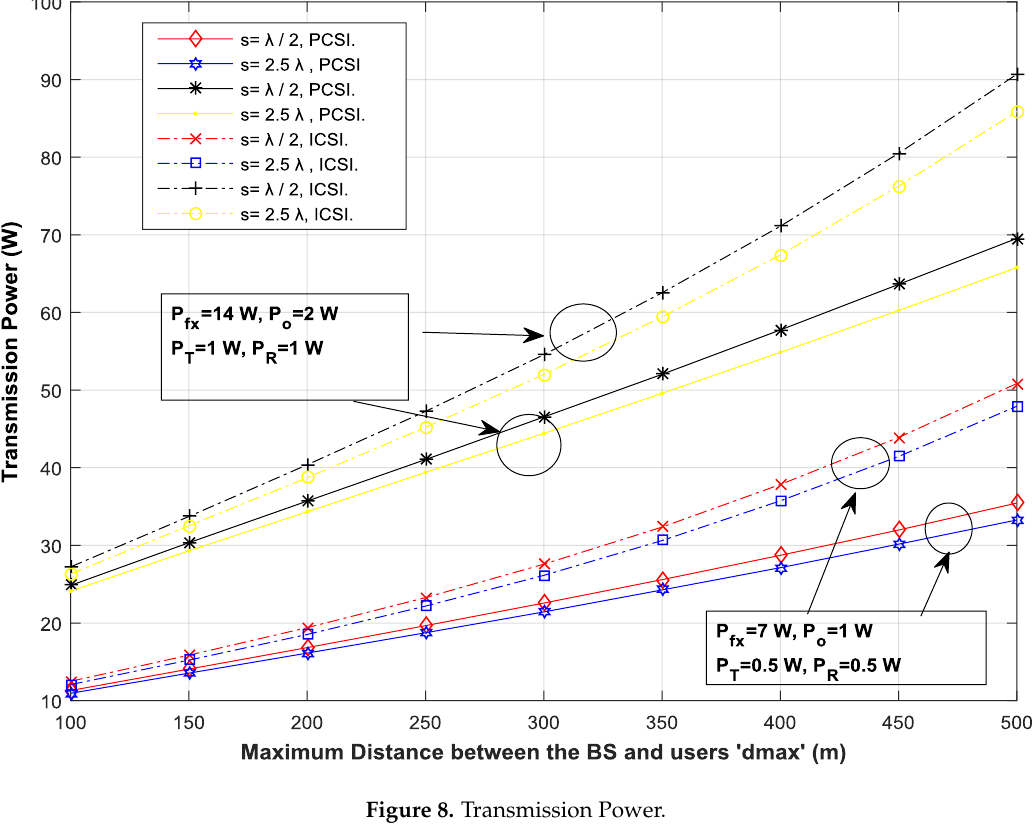
Figure 8. Transmission Power.